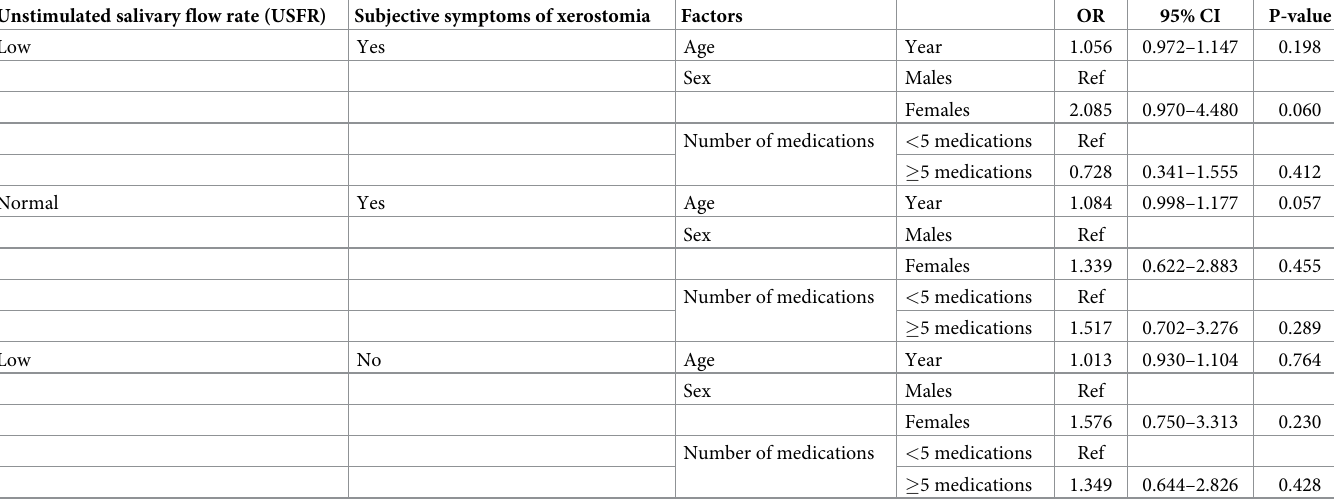
Reference category for dependent variable: Group with normal unstimulated salivary flow rate (USFR) and without subjective symptoms of xerostomia. OR: Odds ratio, CI: Confidence interval, Ref: Reference.